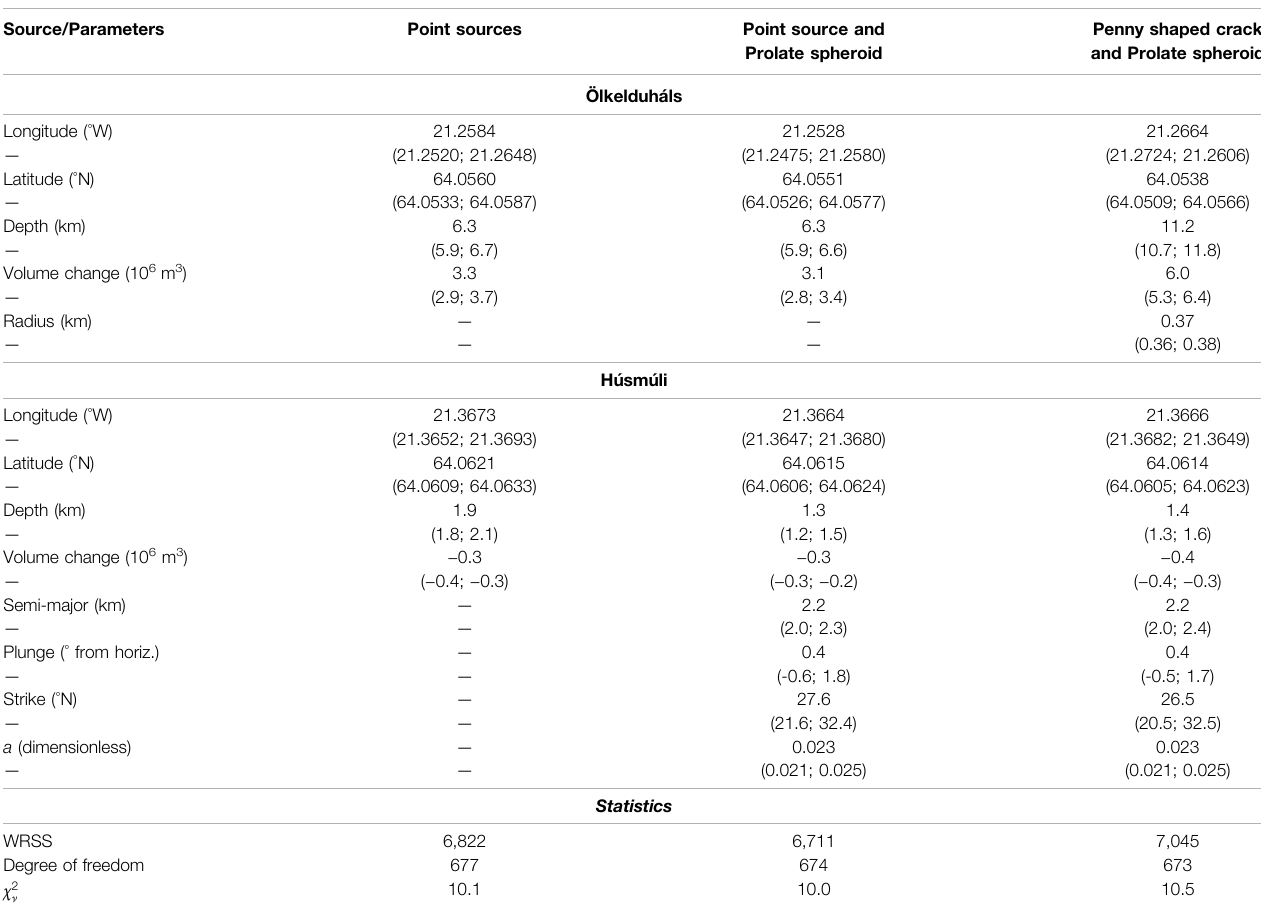
TABLE 2 | Best- fi t solutions of the joint inversion of GNSS and InSAR displacements for the Ölkelduháls and Húsmúli sources. Results of three models are presented here: two point sources, a prolate spheroid and a point source, and fi nally a penny-shaped crack and prolate spheroid source. a signi fi es the aspect ratio of the prolate spheroid source. In brackets are the 95% con fi dence intervals for each parameter. The reduced Chi square ( χ 2 ] ), weighted residuals sum squared (WRSS) and degrees of freedom presented here were calculated using GNSS and subsets of the subsampled InSAR displacements. The preferred model ensuing our statistical test is highlighted in